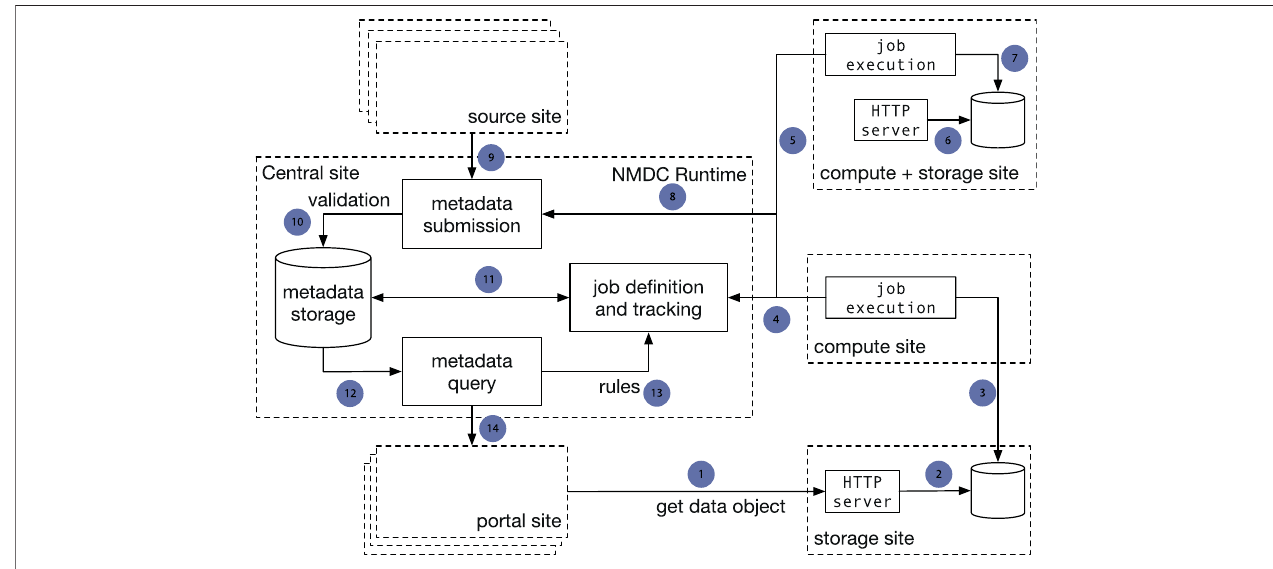
FIGURE1| ImplementationofadatafederationmodelintheNMDCpilot.ThecentralsiteimplementstheNMDCRuntimeAPIthatorchestratesthedata fl owwitha databasethatserves asthedataregistry. The Runtime validates submitted metadata against theNMDCschemaand detects newjobstobe donebasedon submitted- dataannotations.Sourcesitessubmitrawexperimental dataandsamplemetadatatothecentralsite.ComputesitespolltheRuntimefornewwork fl owjobstobedone, claimjobsappropriatefortheircapabilities,andsubmitwork fl owjoboutputstothecentralsite.Storagesitesstorerawwork fl owoutputs.Theportalsiteprovidesa web-based interface. One site can serve as both a computing site and storage site. Arrows: 1): Portal site gets data object from HTTP server at a storage site; 2): The HTTP server retrieves data from a database; 3) A compute site deposits work fl ow run result data to a database at a separate storage site; 4) Compute sites claim computingjobsandprovidejobexecutionupdatestothejobtrackingmechanismattheCentralsite;5,6,7):Acomputesitecanalsoserveasastoragesiteatthesame time; 8) Compute jobs are associated with the sample metadata; 9) A source site submits sample metadata to the Central site; 10) Central site validates submitted